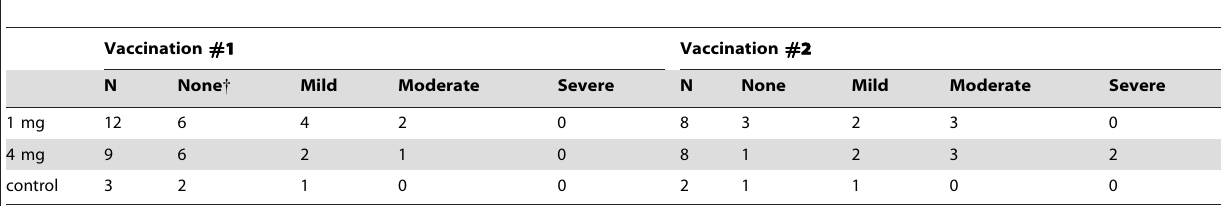
Table 3. Systemic reactions* within 7 days of